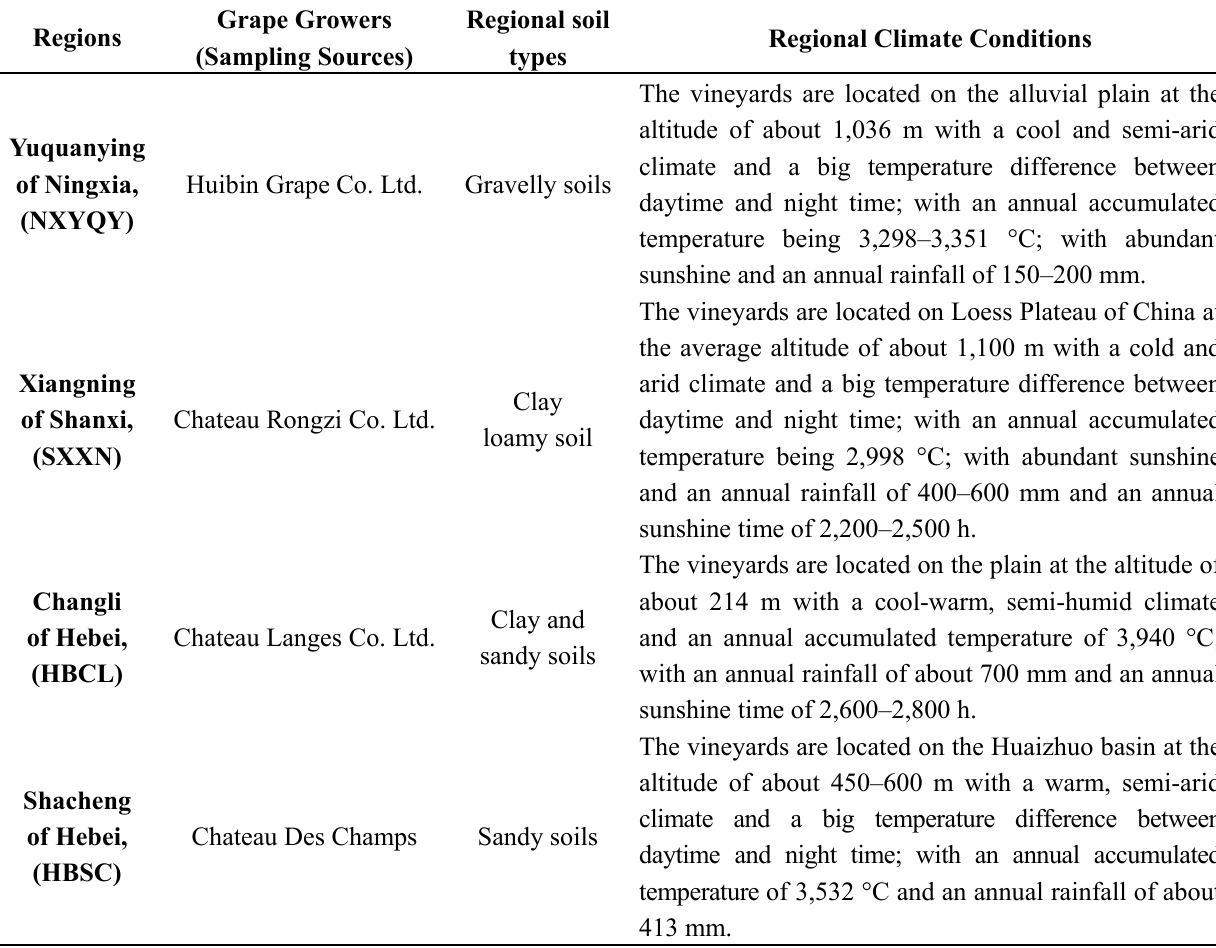
Table 5. Grape grower, regional climate condition, and soil type from four different wine grape